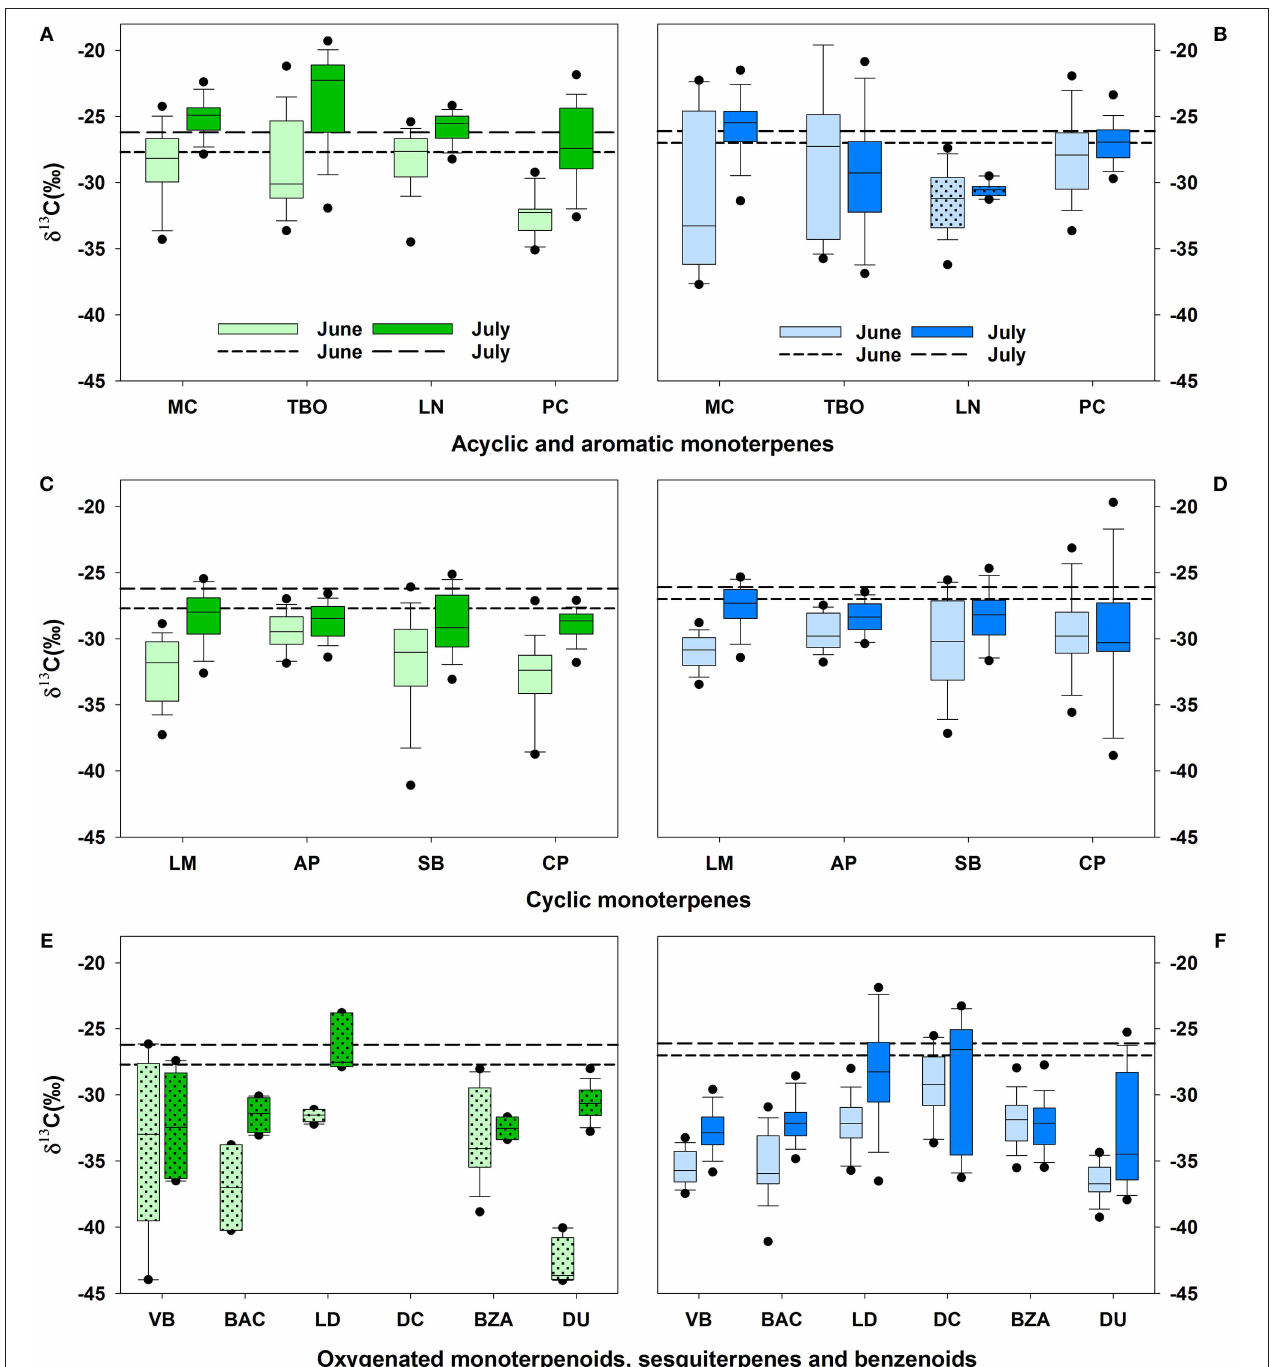
FIGURE 3 | BVOC carbon isotope composition for acyclic and aromatic monoterpenoids (A, B) , cyclic monoterpenes (C, D) , and oxygenated monoterpenoids, sesquiterpenes, and benzenoids (E,F) for Q. suber (green, A,C,E ) and C. ladanifer (blue, B,D,F ) with 5 and 95 % percentile. Please see Table 2 for sample size for each compound and species. Short dashed lines represent the δ 13 C values of the carbon source in June; long dashed lines represent the δ 13 C values of the carbon source in July. For dotted boxplots, only few δ 13 C values were obtained. MC, myrcene; TBO, trans- β -ocimene; LN, linalool; PC, p-cymene; LM, limonene; AP, α -pinene; SB, sabinene; CP, camphene; VB, verbenone; BAC, bornyl acetate; LD, ledene; DC, δ -cadinene; BZA, benzaldehyde; DU, durene.